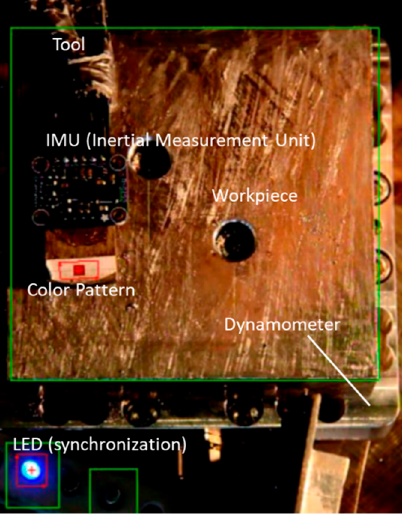
Figure 4. Camera image during actual measurement of the hand scraping process.